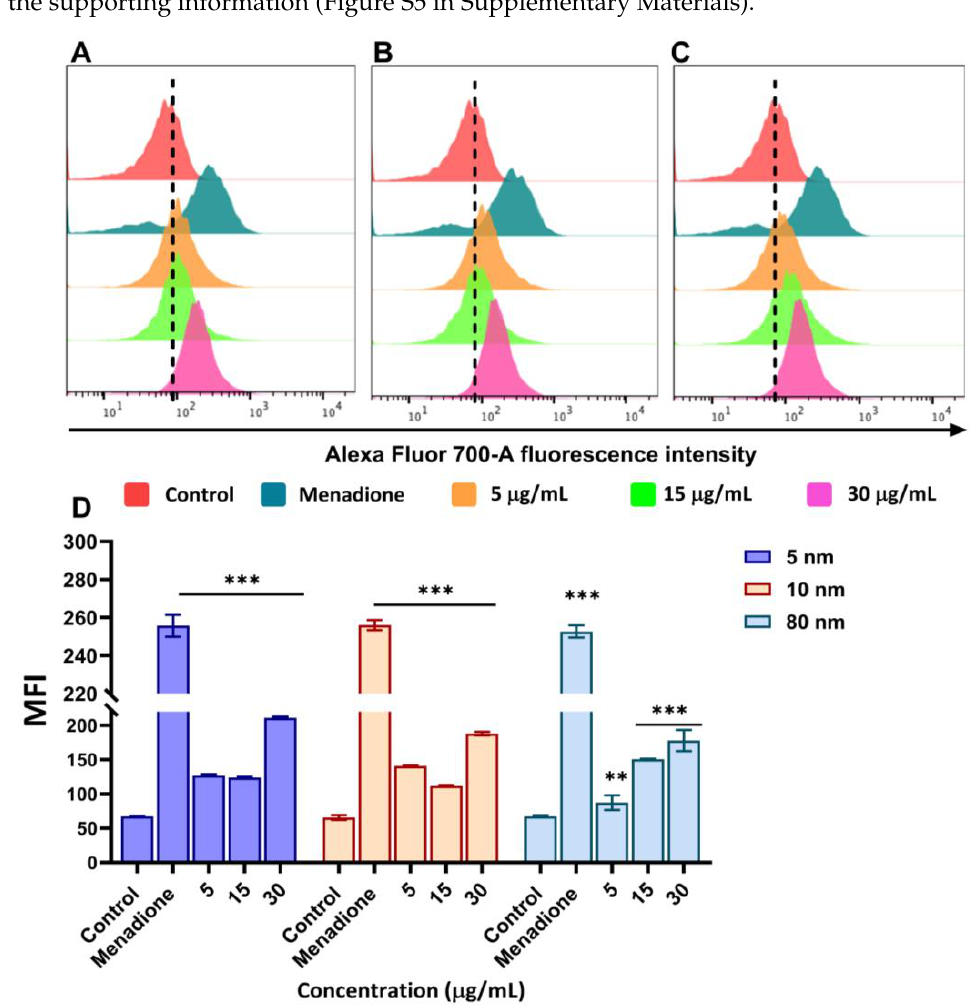
Figure 5. ROS production in A549 cells following exposure to different sizes of AuNPs analysed using flow cytometry with the CellRox deep red kit. Histograms of flow cytometry treated with ( A ) 5 nm ( B ) 10 nm and ( C ) 80 nm AuNPs. ( D ) Bar graphs represent the median fluorescence intensity (MFI) of A549 cells exposed to 5, 10, and 80 nm AuNPs. Menadione (50 µM) was used as a positive control. Plotted graphs represent the means ± SD of three independent experiments. Bars with an asterisk (*) show a statistical difference (** p < 0.01, and *** p < 0.001) when compared with the control.